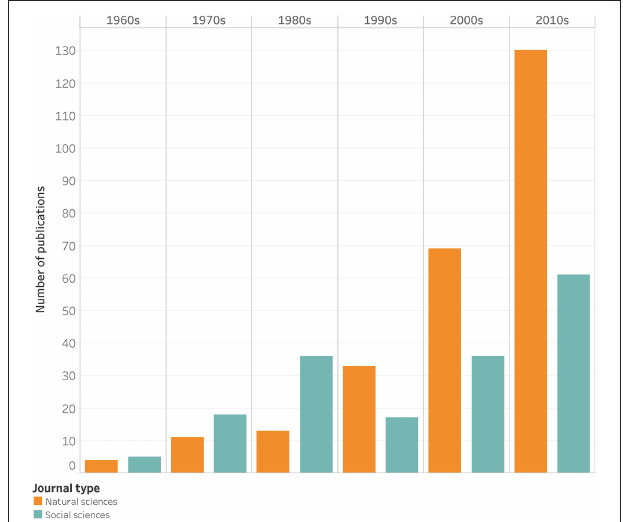
FIGURE 3 | Total number of publications by journal type and decade published in the sample ( n =